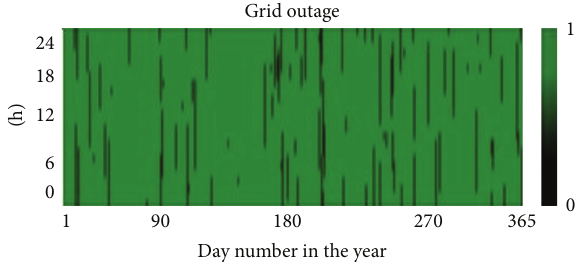
Figure 10: Reliability of national grid.